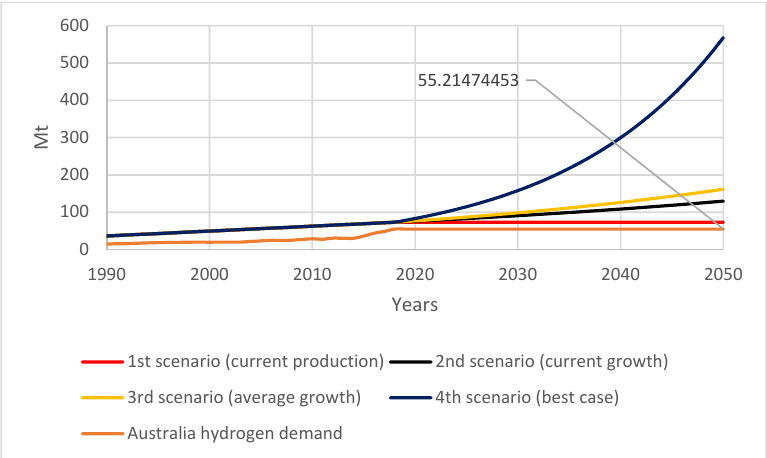
Appl. Sci. 2022 , 12 , x FOR PEER REVIEW Figure 9. The potential global demand for hydrogen for the four scenarios. Figure 9. The potential global demand for hydrogen for the four scenarios.